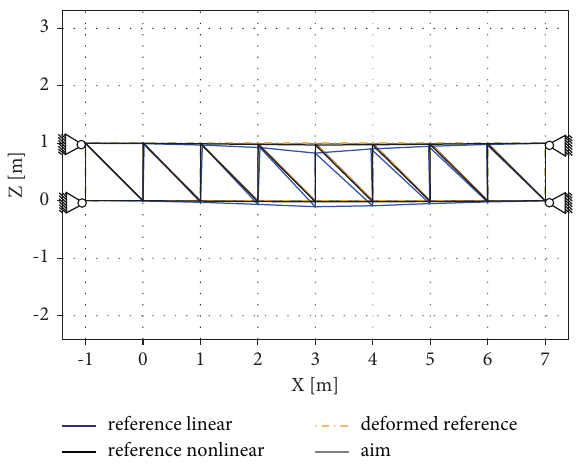
Figure 16: Bridge confgurations in x − z plane for y � 0.